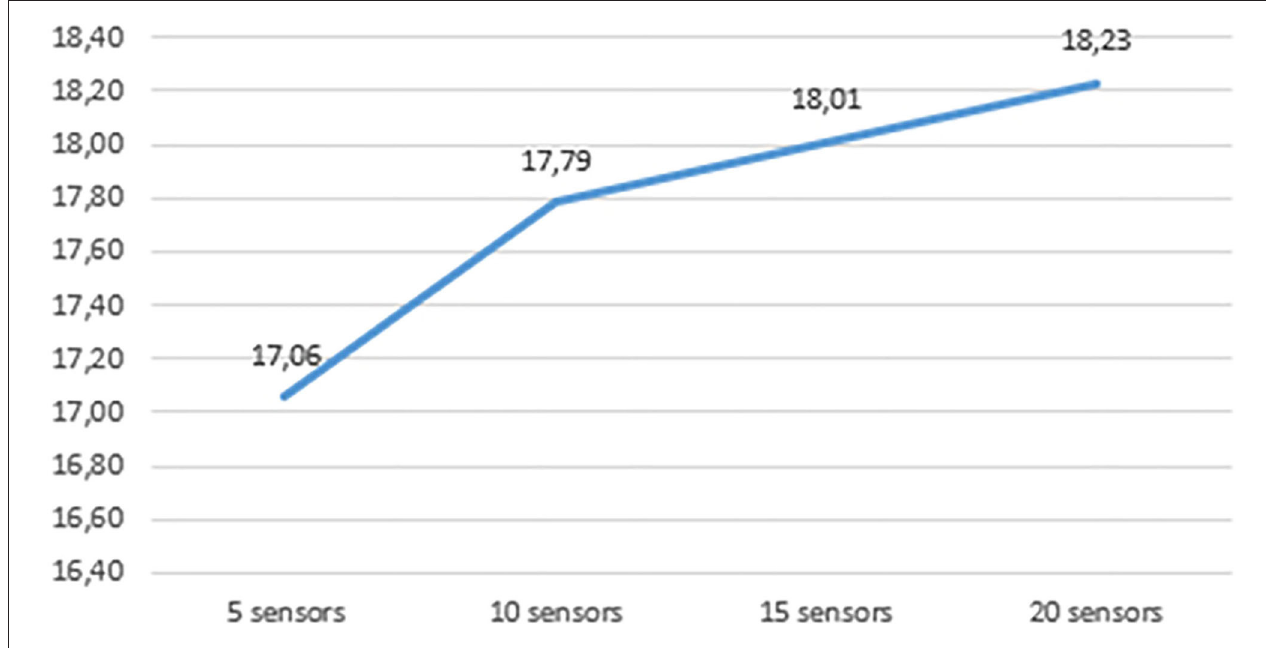
FIGURE 4 | Pattern engine average